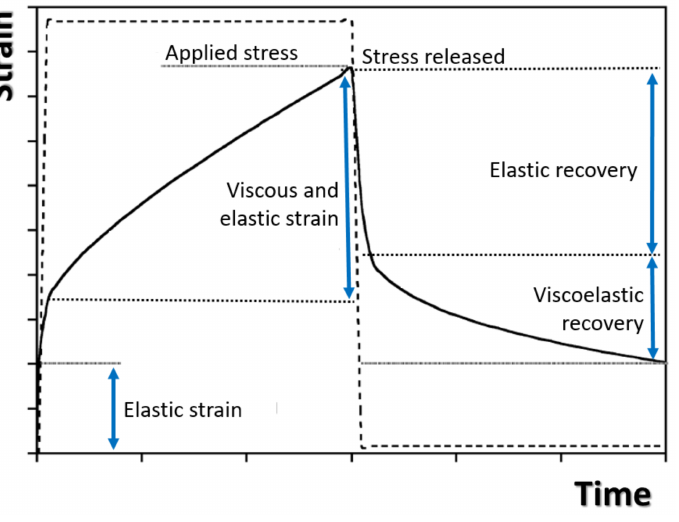
Figure 7. Typical creep and Relaxation Burger Model